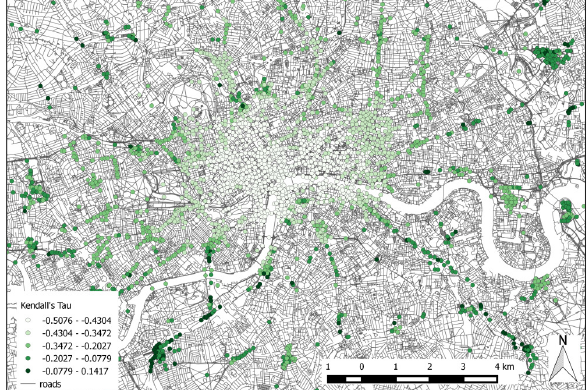
Figure 8: Average cosine similarity within 50 meters